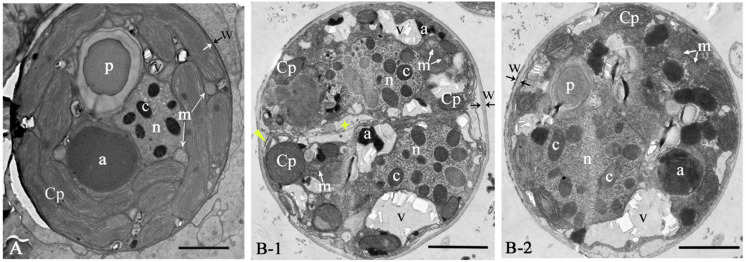
The ultrastructure of Cladocopium sp. C1 from coral G. fascicularis. (A)
in situ; (B-1/B-2) GF19C1, in vitro cultured. Panel (B-1) is the newly divided cell, showing new cell membranes (star) and cell wall forming (triangle). a, accumulation body; c, chromosome; Cp, chloroplast; m, mitochondrion; n, Nucleus; p, pyrenoid; v, vacuole; w, cell wall, paired arrows indicate the thickness of the cell wall. Scale bars = 2 μm.